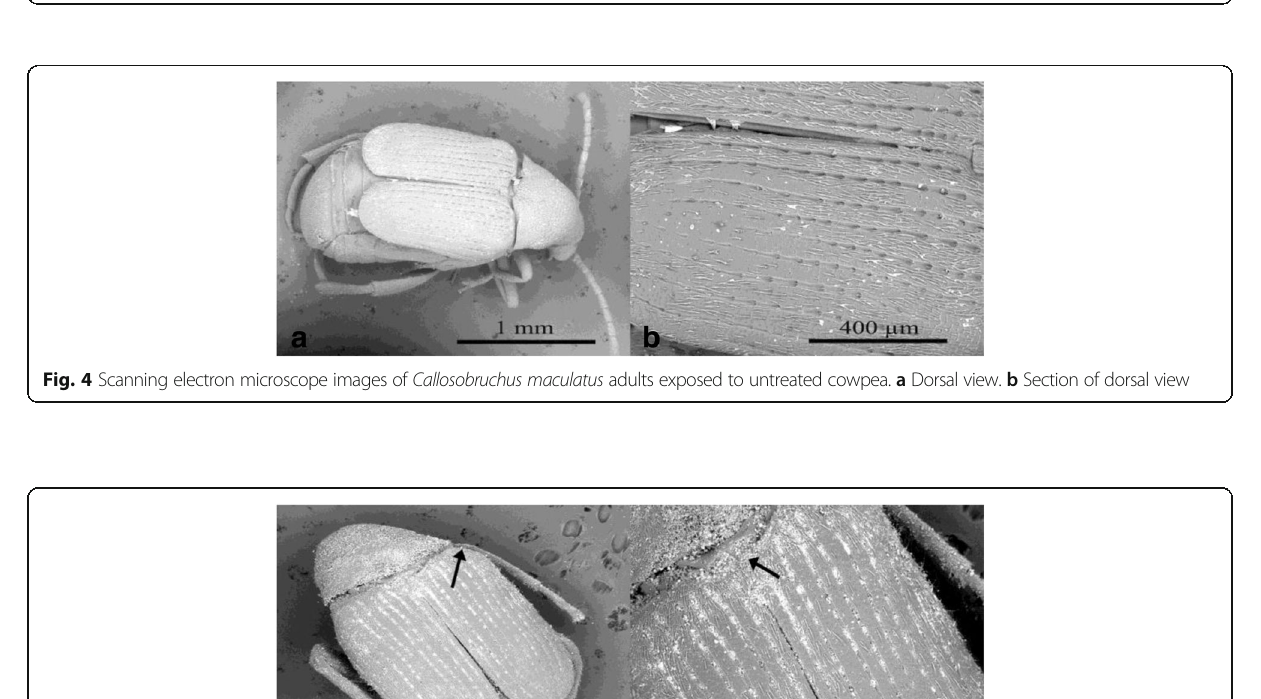
Fig. 3 Scanning electron microscope images of Tribolium confusum adults exposed to 225.5 ppm of nano zeolite treated wheat. a Dorsal view, particles of nano zeolite aggregate on insect surface and on leg joints (arrows). b Section of dorsal view, particles of nano zeolite aggregate between thorax and abdomen joints (arrow)